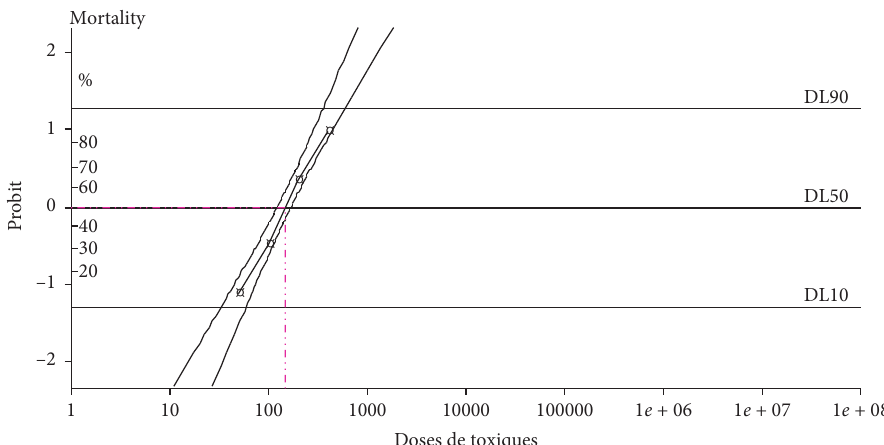
Figure 3: A graphic representation showing the LC 50 and LC 90 values of L. angustifolia subsp. E. Oil after 24 h of exposure.